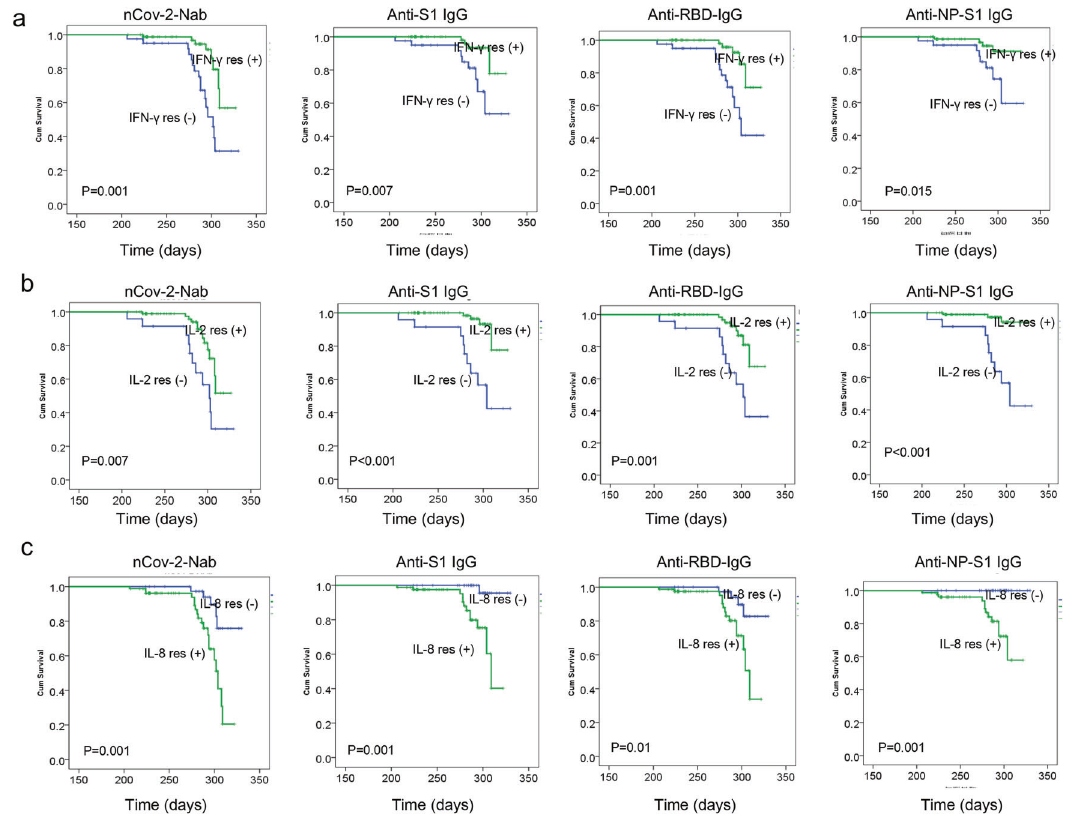
Fig. 6 SARS-CoV-2 antigen-activated cytokine responses associated with antibody survival. Kaplan – Meier analysis of the association of antigen-activated IFN- γ responses and antibody survival ( a ), the association of antigen-activated IL-2 responses and antibody survival ( b ), and the association of antigen-activated IL-8 responses and antibody survival ( c